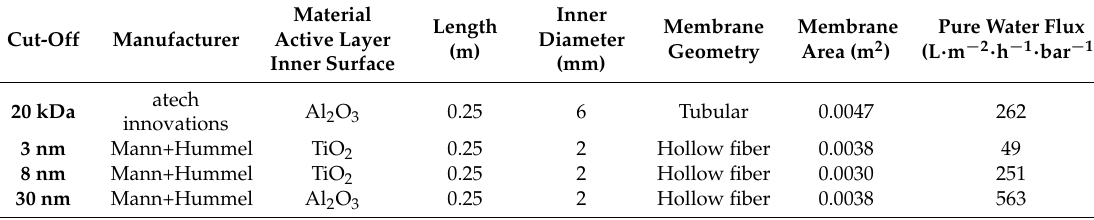
Table 1. Properties of the ceramic membranes compared in this